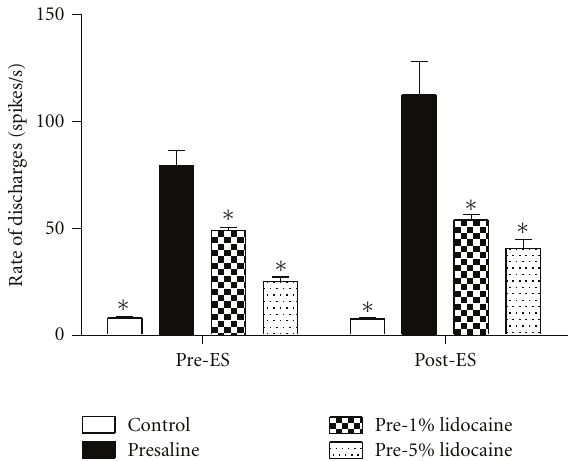
Figure 3: Average rate of discharges (spikes/sec) in di ff erent treat- ment groups at pre-electrical stimulation (pre-ES), and postelectri- cal stimulation (post-ES) stages. The rates of discharges decreased with increasing doses of lidocaine pre-treatment compared with the presaline group ( (cid:0) P 0 . 05 compared with the presaline group). (cid:0)